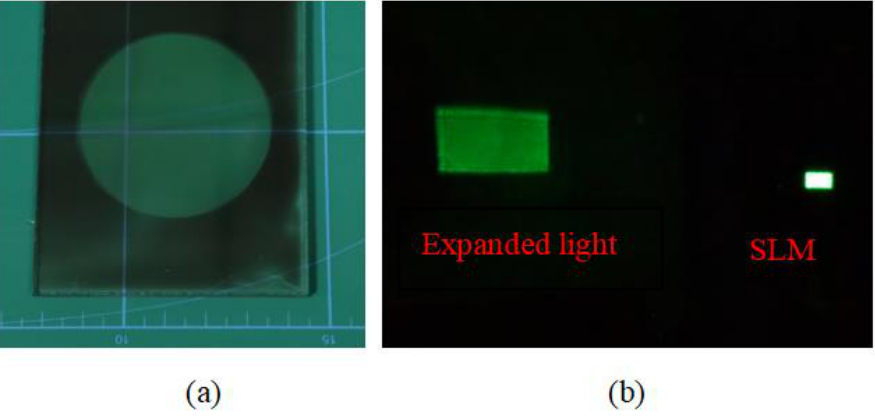
Figure 14. Results of the HOE. ( a ) HOE sample; ( b ) result of the beam expansion and reflection by using the HOE.